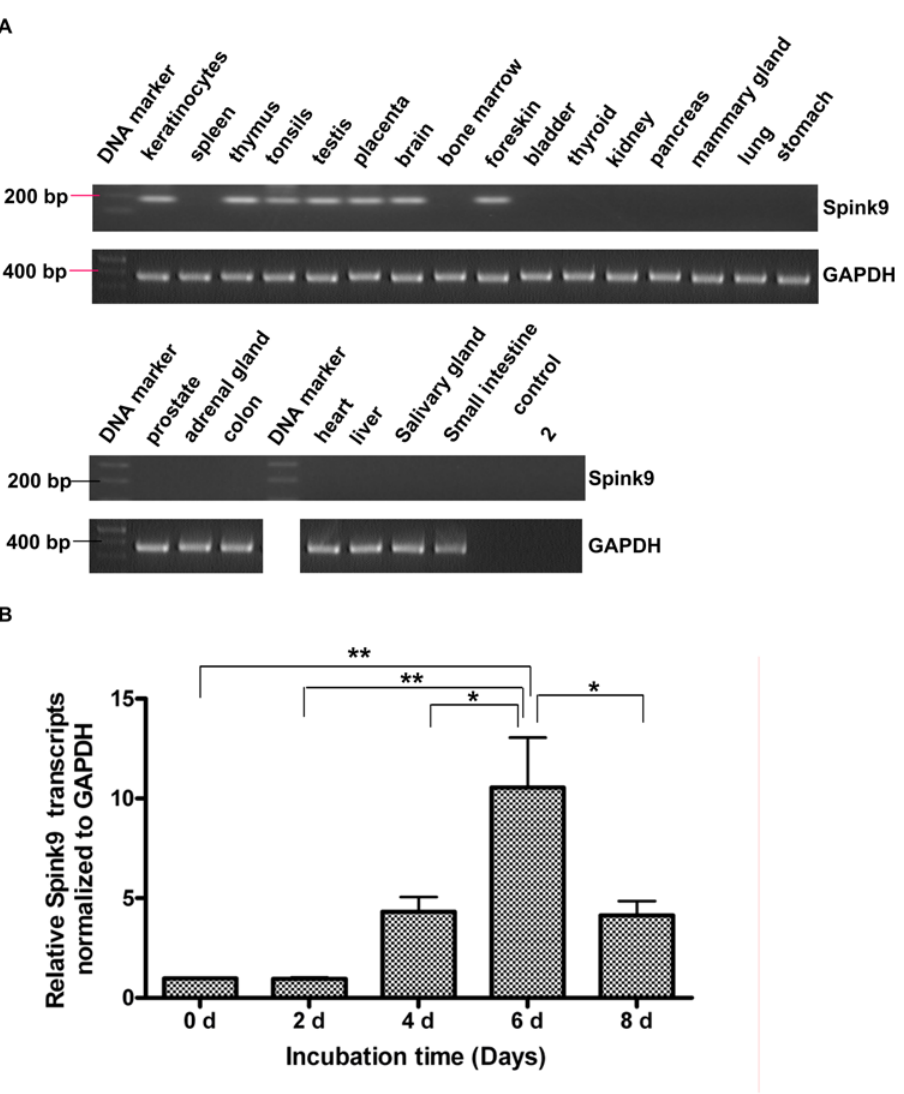
Figure 3. Spink9 mRNA expression in human skin and keratinocytes. (A) Expression profile of Spink9 mRNA. Fragments were obtained after RT-PCR amplification on human multiple tissue cDNAs with primers specific to the human GAPDH and Spink9 . Lanes are labelled according to the template tissue. The Spink9 fragments are of 175 bp in size. H 2 O (no cDNA) and RT-control (no RNA template) were used as negative controls. (B) Spink9 mRNA expression in cultured primary keratinocytes. Quantitative realtime PCR was conducted on RT-PCR products of total RNA samples collected from keratinocytes treated with 1.0 mM CaCl 2 for the indicated time. Bar graphs represent the relative mRNA expression of Spink9 against GAPDH . Data are obtained from three independent experiments with different sources of keratinocytes and are indicated as the mean + / 2 SD. * indicates significant (p , 0.05); ** indicates significant (p , 0.01).